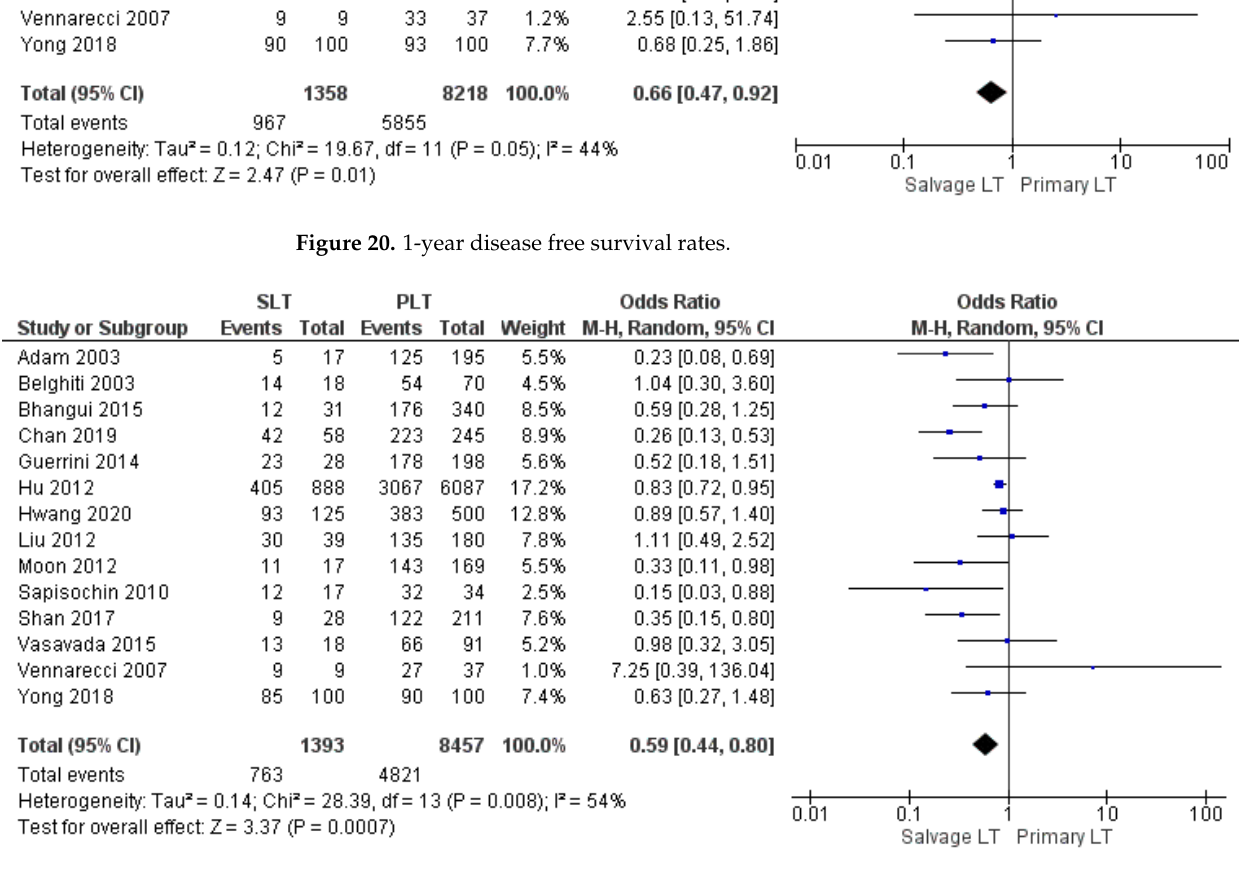
Figure 21. 3 - year disease free survival rates.